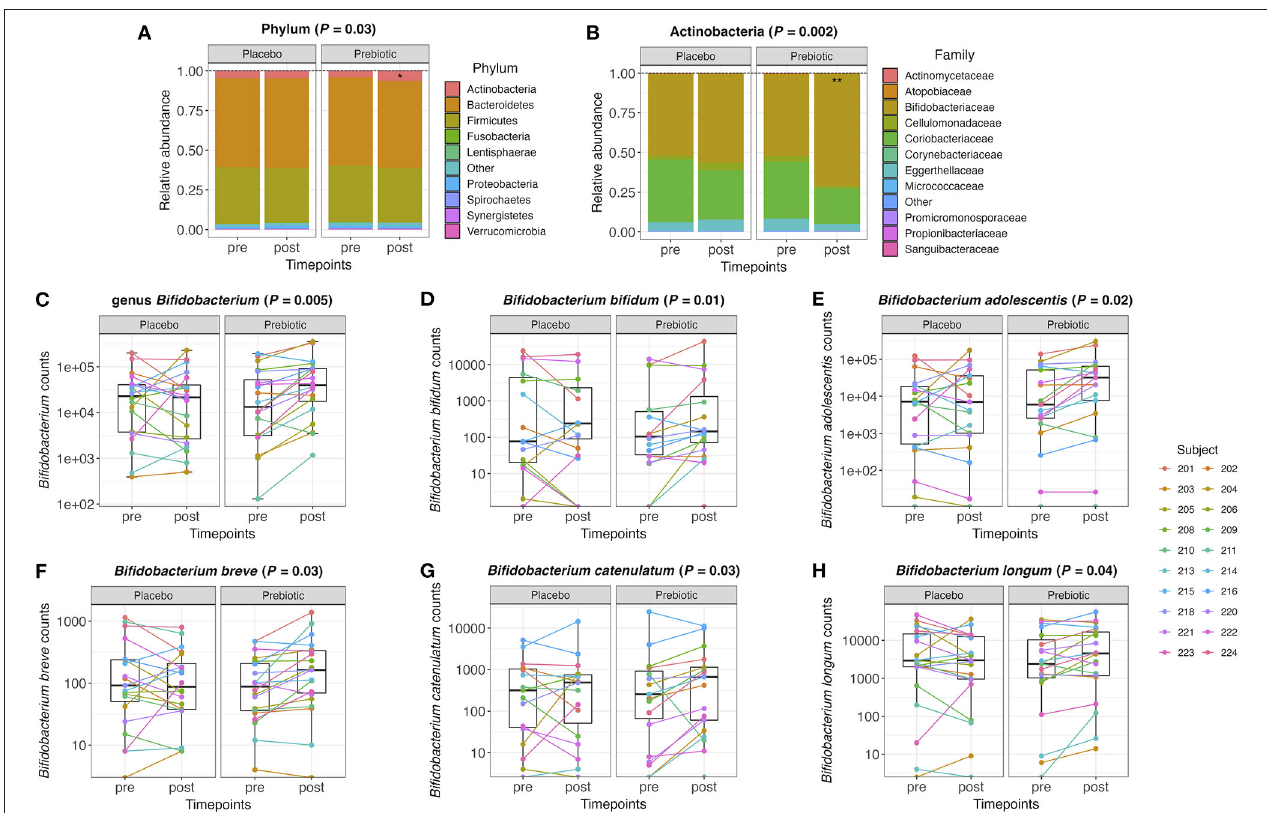
FIGURE 2 | (A) Relative abundance of the gut microbiome at the phylum level and (B) the family level within the phylum Actinobacteria pre- and post-treatment with placebo or prebiotic. (C) Box plots of the genus Bifidobacterium counts pre- and post-treatment with placebo or prebiotic. (D–H) Box plots of Bifidobacterium species counts pre- and post-treatment with placebo or prebiotic (* P < 0.05, ** P <